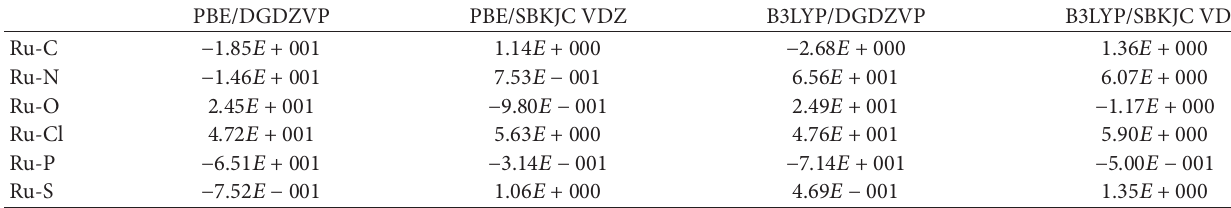
Table 7: 𝐽 -coupling of the Ru-L bonds at different level of computational methods.